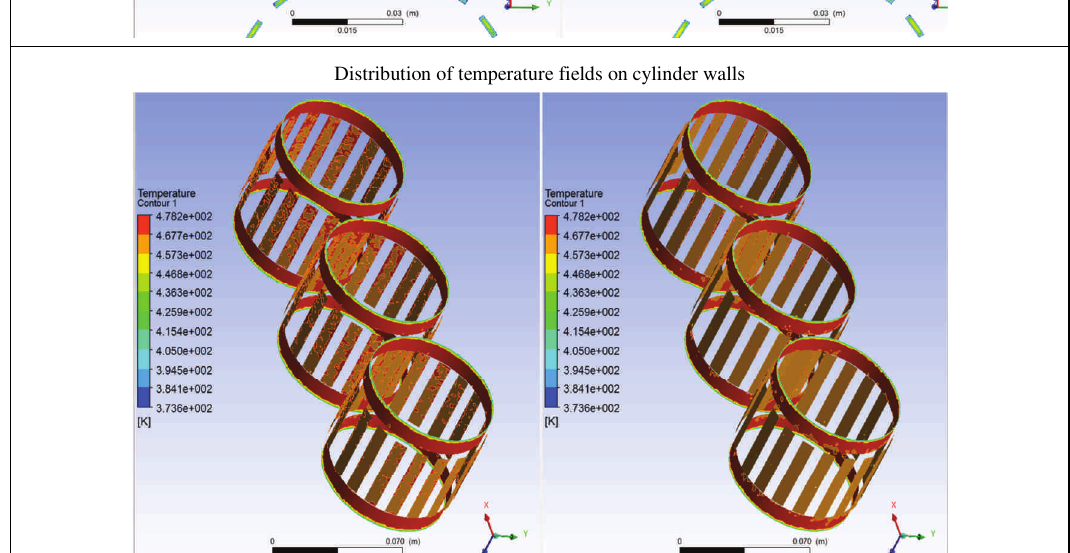
Fig. 11. Distribution of velocity and temperature fields for the computational grid with a minimum element size of 0.8 mm (left side) and 0.6 mm (right